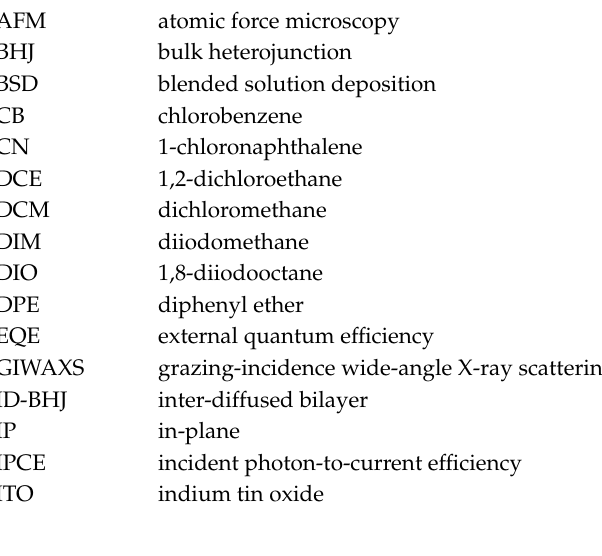
Figure S1: UV-absorption spectra of as-cast PCPDTBT film and after spin casting with each solvent. ( a ) Chlorobenzene (CB), ( b ) chloroform (CF), ( c ) o-dichlorobenzene (DCB), ( d ) 1,2-dichloroethane (DCE), ( e ) dichloromethane (DCM), ( f ) diiodomethane (DIM) and ( g ) toluene. Figure S2: (a) UV absorption spectra of the PC 71 BM solution with different concentrations. (b) The absorbance values obtained from 460 nm plotted with the concentration. The red star marks the absorbance of the diluted solution. Figure S3: Surface topography of ( a ) DCE-, ( b ) 1 vol % DPE-containing DCM- and ( c ) 1 vol % DPE-containing DCE-casted PC 71 BM films. Figure S4: DCM-casted PC 71 BM at ( a ) below RT and ( b ) 60 ◦ C. DCE-casted PC 71 BM at ( c ) below RT ( d ) and 60 ◦ C ( e ). PCE and J SC are dependent on the processing temperature. Figure S5: The surface topography of ordering agent-driven PCPDTBT film scanned by an atomic force microscope (AFM). (1 × 1 µ m). ( a ) PCPDTBT(N). ( b ) PCPDTBT(C5). ( c ) PCPDTBT(D5). Figure S6: Original grazing-incidence wide-angle X-ray scattering (GIWAXS) diffraction patterns of Figure 7d–e. ( a ) PCPDTBT(N). ( b ) PCPDTBT(C5). ( c ) PCPDTBT (D5). Figure S7: In-plane (IP) and out-of-plane (OOP) line-cuts from GIWAXS images. ( a ) IP and ( c ) OOP X-ray scattering profiles of PCPDTBT(C). ( b ) IP and ( d ) OOP X-ray scattering profiles of PCPDTBT(D). Figure S8: Absorption spectra of ordering agent (OA)-added PCPDTBT films. Figure S9: AFM-measured PCPDTBT film surface topography after PC 71 BM(E) removal from ID-BL. ( a ) PCPDTBT(N). ( b ) PCPDTBT(C5). ( c ) PCPDTBT(D5). Figure S10: Photoluminescence (PL) quenching effect of two different types of solar cells. Table S1: Optimization of device performance according to different active layer